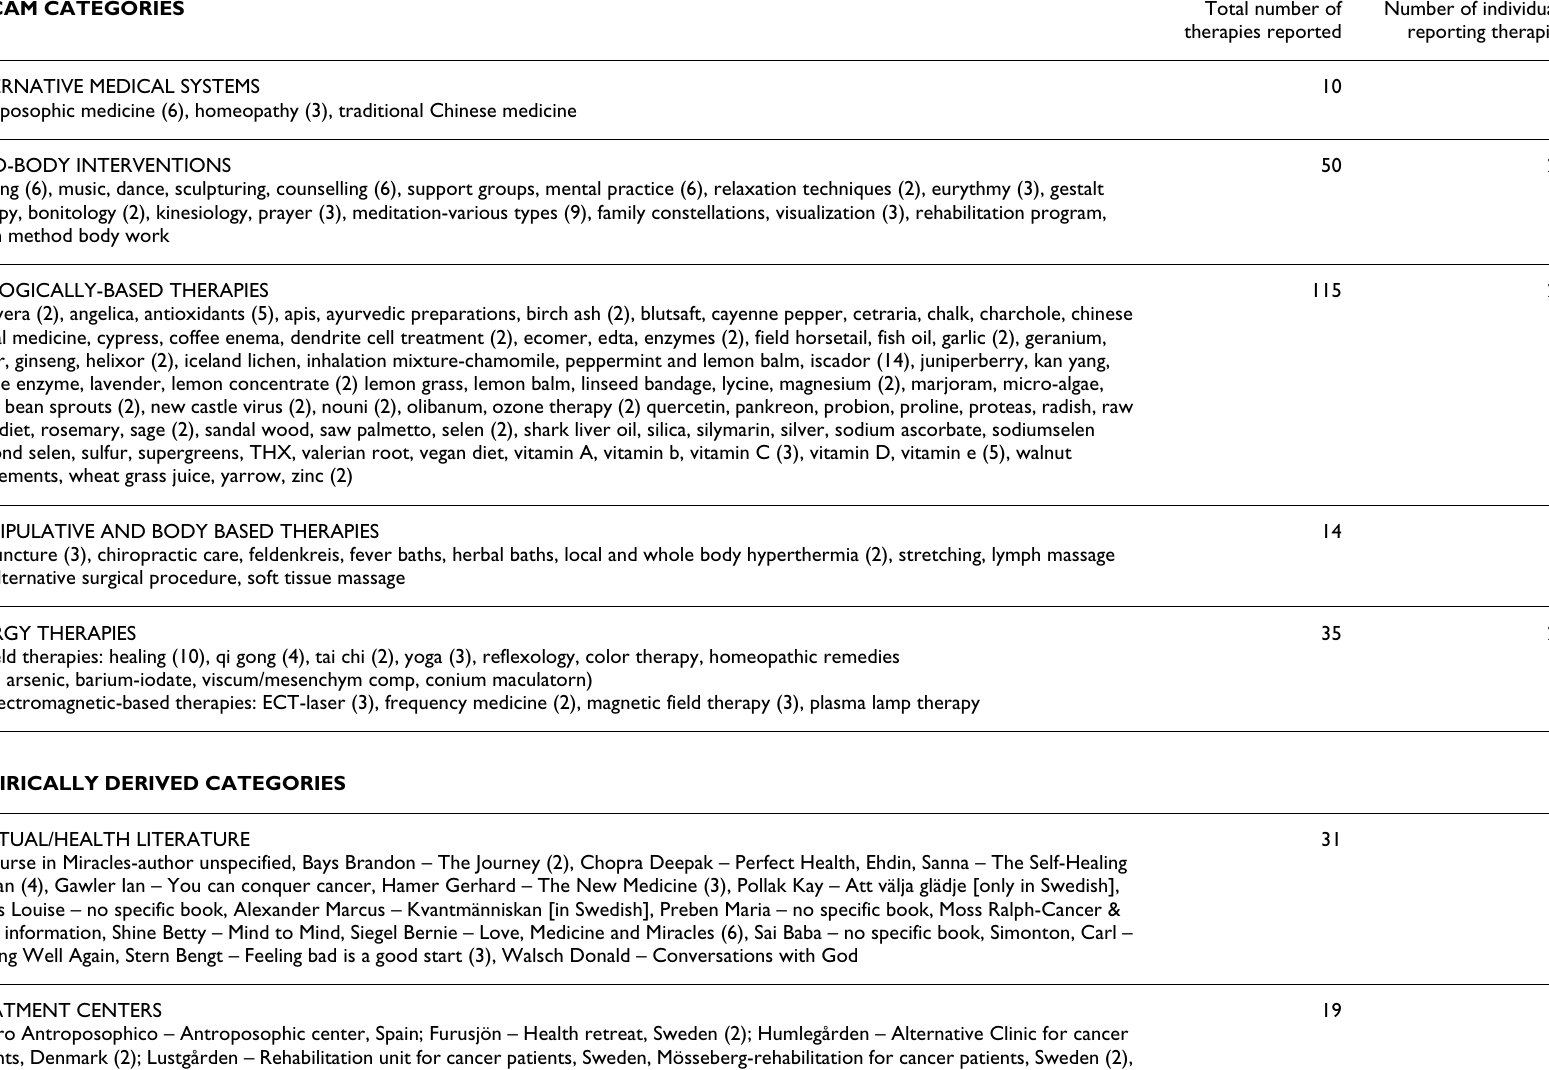
Table 3: CAM described by participants and sorted into seven CAM